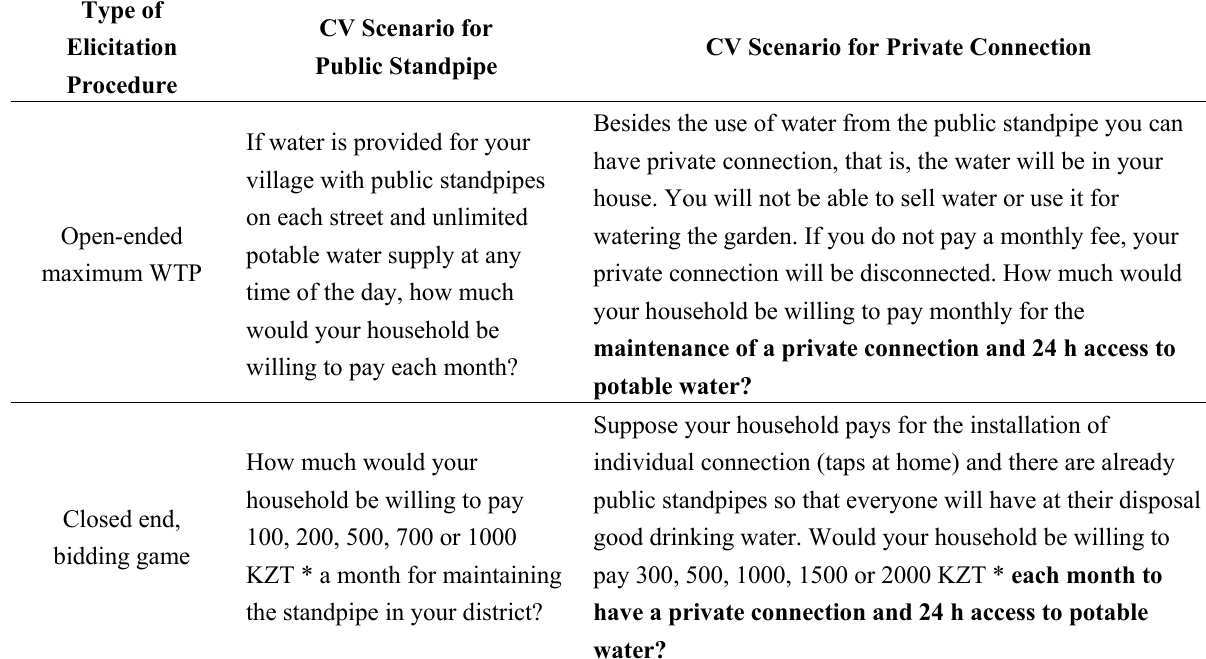
Table 1. CV scenario and the choice of elicitation